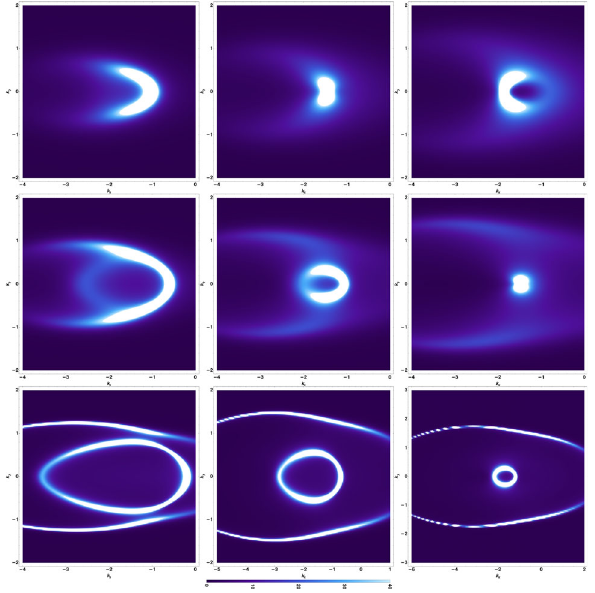
Fig. 3 Here we plotted the spectral density for non-zero fermion mass m ψ = 1 / 4 and charge q = 1 with the background parameters T /μ = 0 . 02 , 0 . 009 , 0 . 001 (top to bottom), k 1 /μ = 0 . 8, k 2 /μ = 0, m 2 φ = 0 and χ ( 1 ) = 2 respectively. We fixed the coupling parameters p 2 = 0 . 3 and vary p 1 = − 0 . 2 , − 0 . 3 , − 0 . 4